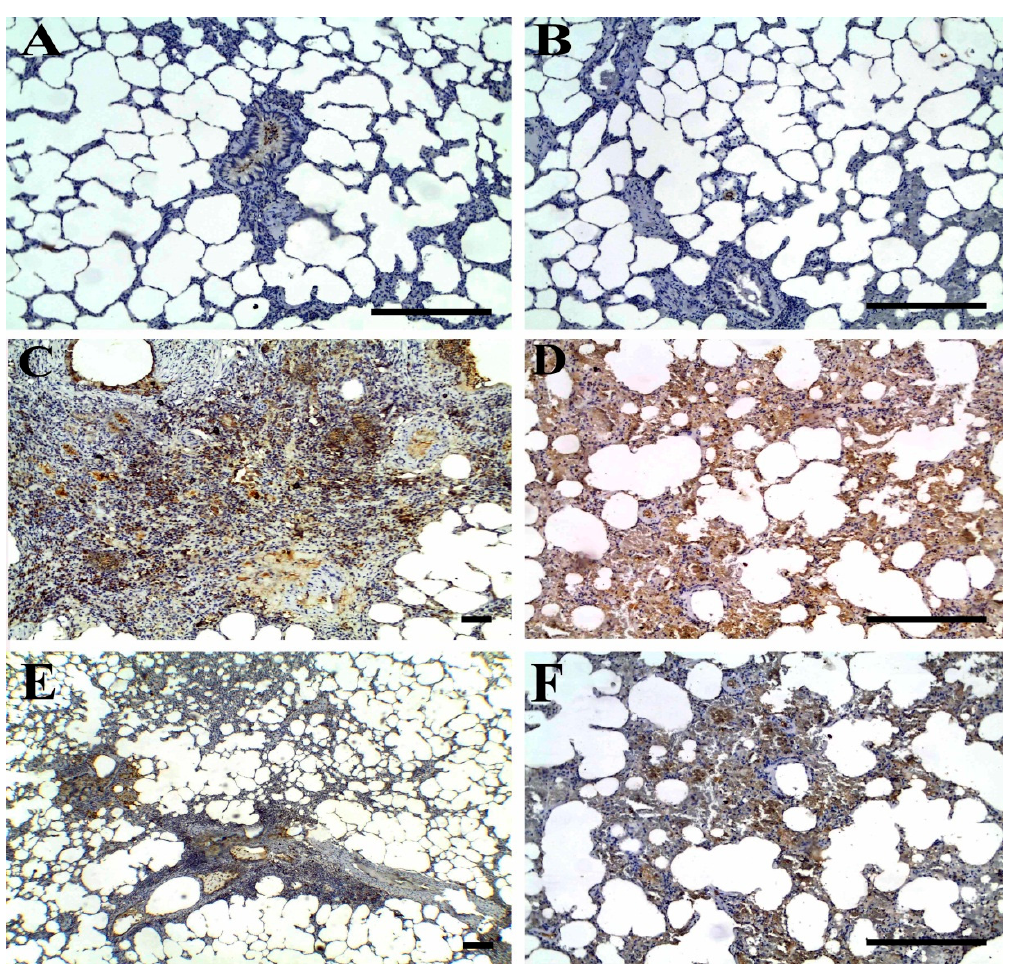
Figure 7. Representative photomicrographs of iNOS immunoreactivity in the lung tissue of Wister rats treated (via intratracheal instillation) with bleomycin, TQ-PLGA-PVA-NPs, or their combination; scale bar = 100 µm. Lung tissues from control ( A ) and TQ-PLGA nanoparticles treated rats ( B ) showed negative iNOS immune expression. Bleomycin-intoxicated rats ( C,D ) exhibited strong iNOS immunoreactivity in peribronchial ( C ) and interalveolar ( D ) (higher magnification) tissues. Lung tissues from rats co-treated with TQ-PLGA-PVA-NPs ( E,F ) show mild to moderate iNOS immunoreactivity in peribronchial ( E ) and interalveolar ( F ) (higher magnification) tissues.